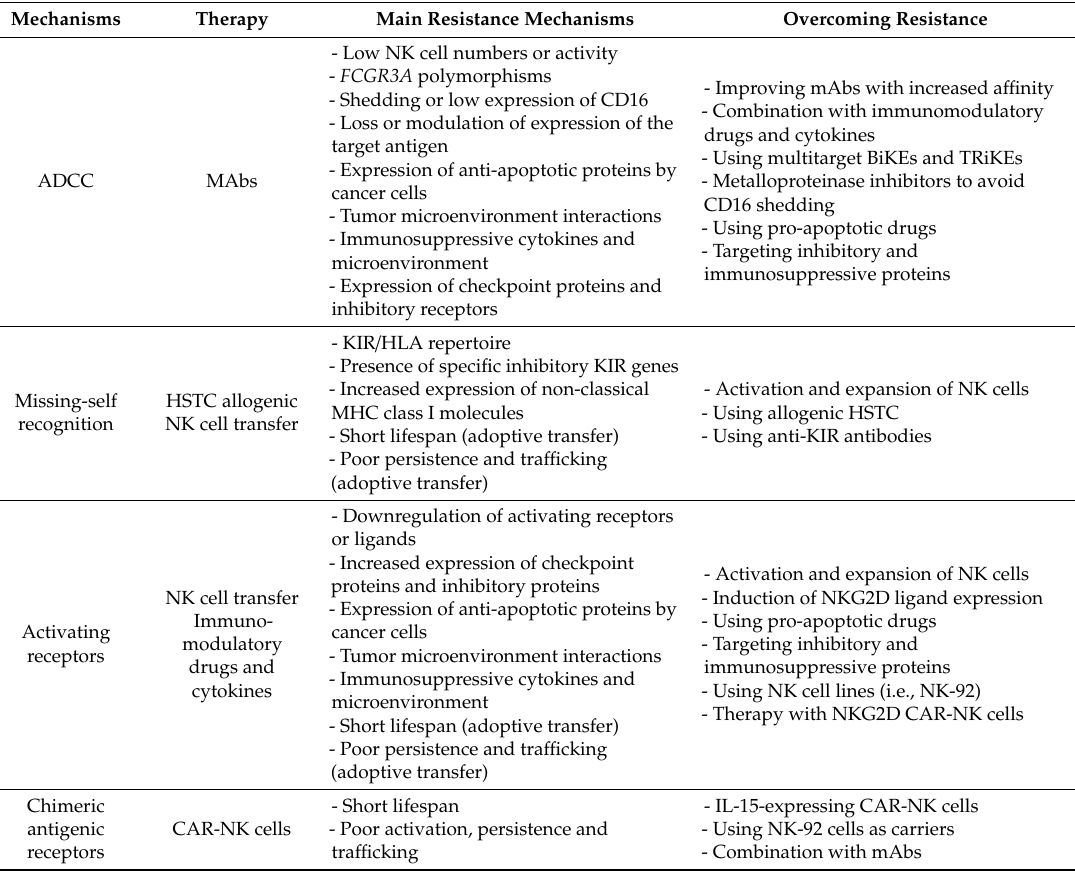
Table 1. Resistance to natural killer (NK) cell-based